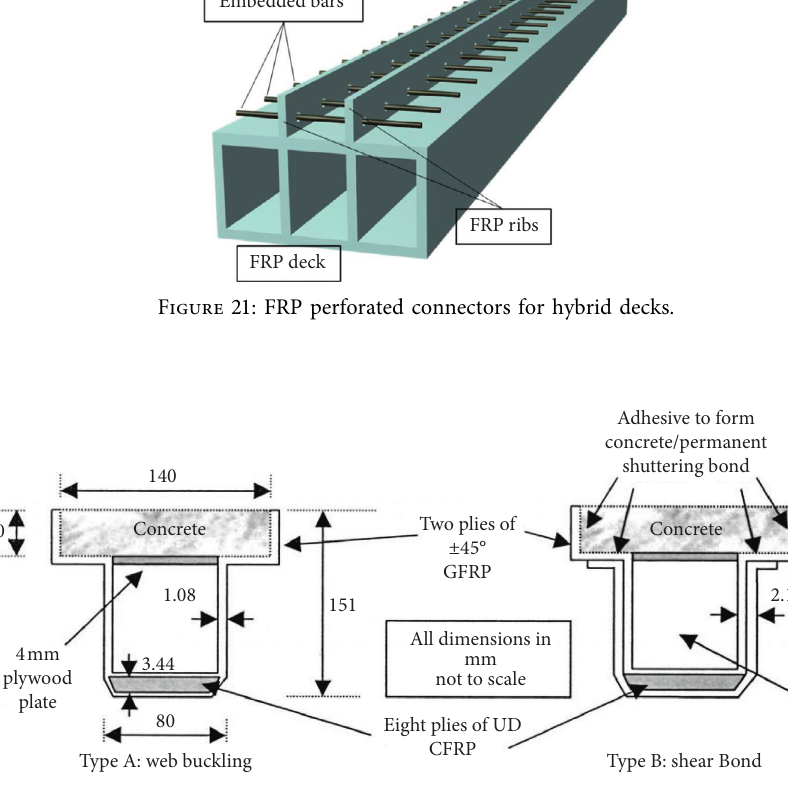
Figure 22: Completed cross-sections including basic